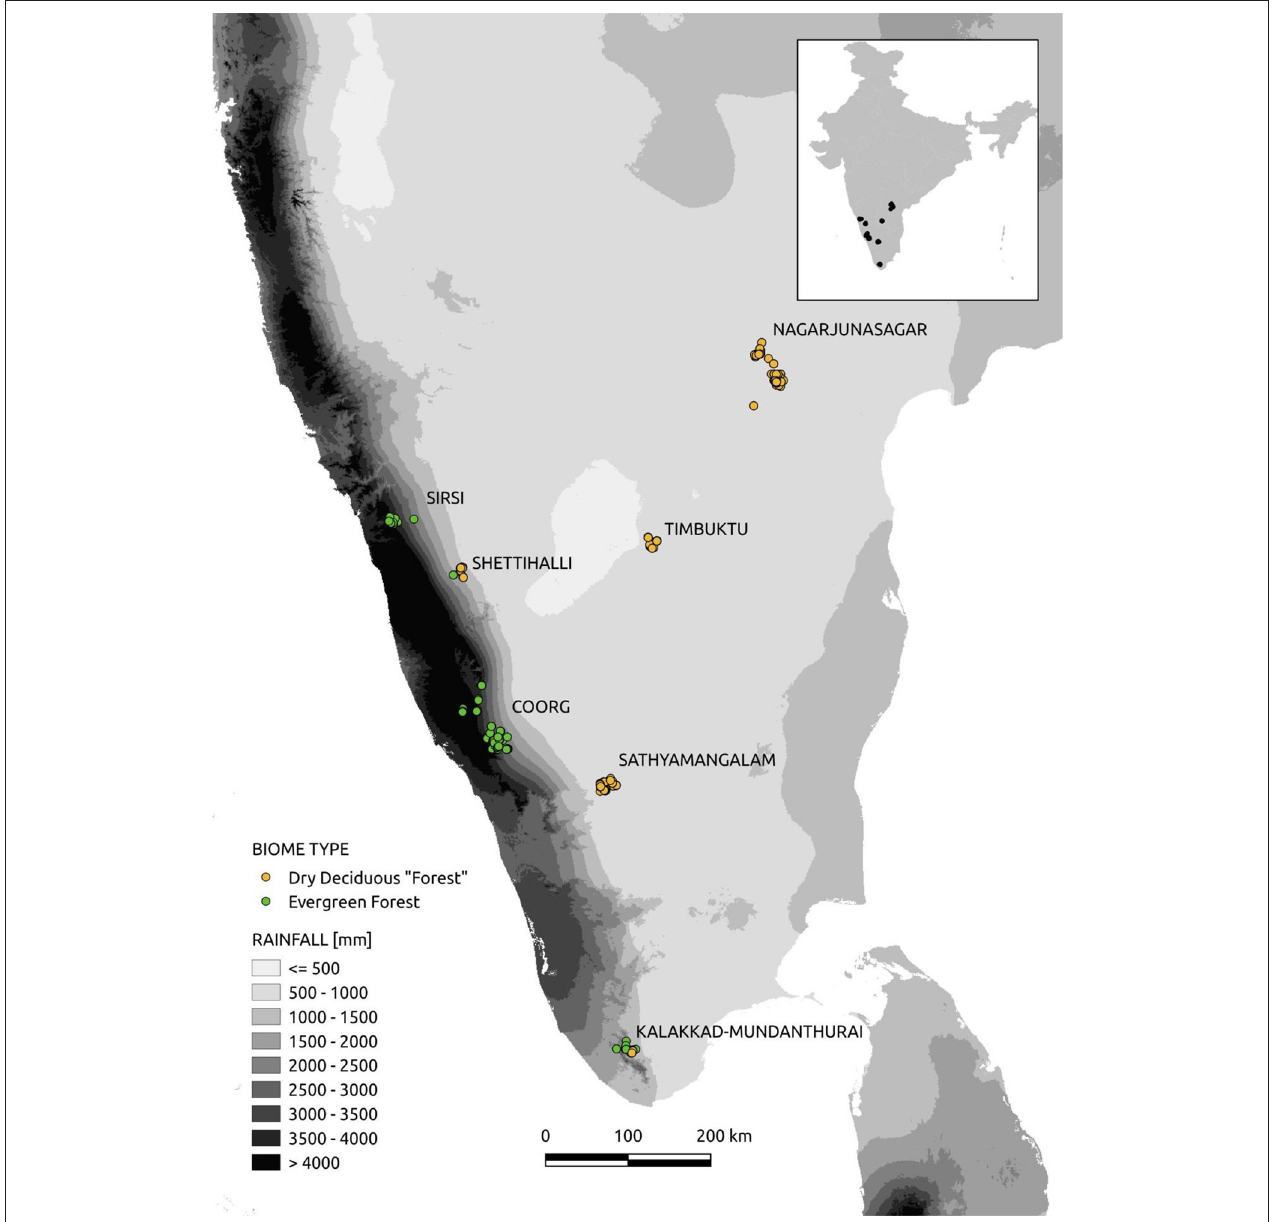
FIGURE 1 | Sampling sites across Southern India. Sites span a rainfall gradient from a little over 500mm to over 4,000mm per year. Rainfall is seasonal and all sites have long dry seasons ranging from 5 to 8 months.